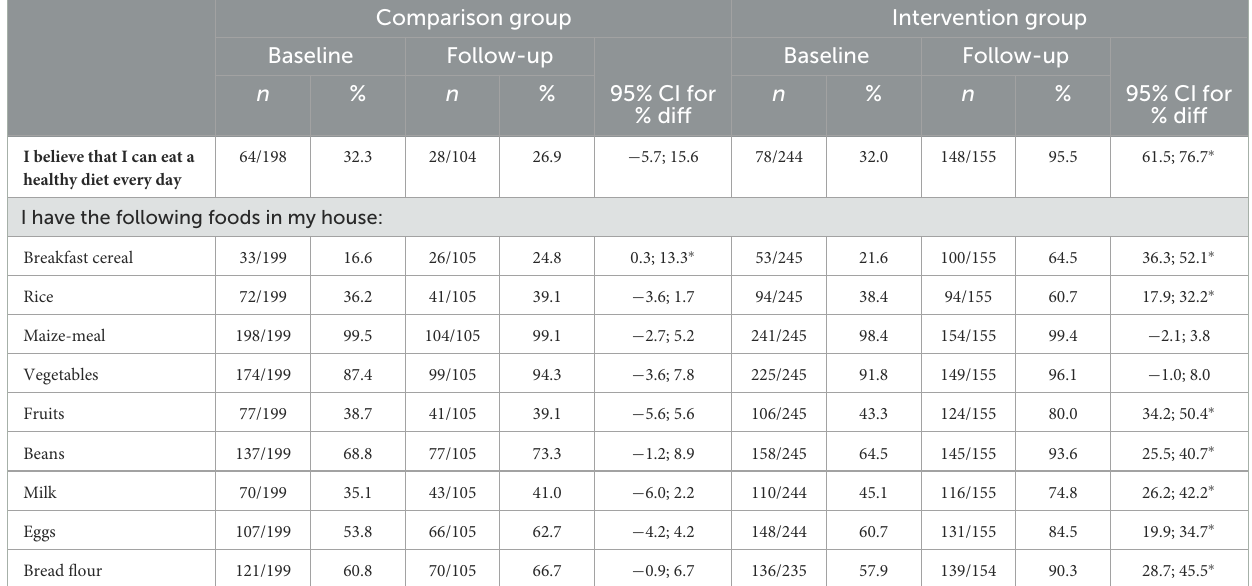
TABLE 2 Changes in health-related actions. Comparison group Intervention group Baseline Follow-up Baseline